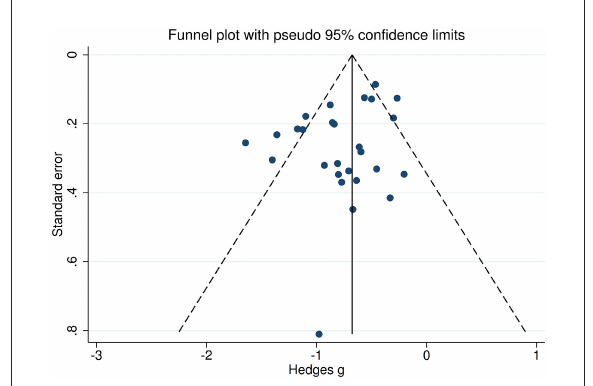
FIGURE7 Funnel plots of the actual meta-analyses. The vertical and diagonal dashed lines represent the overall estimated effect size and its 95% confidence limits, respectively, based on the random-effect model.